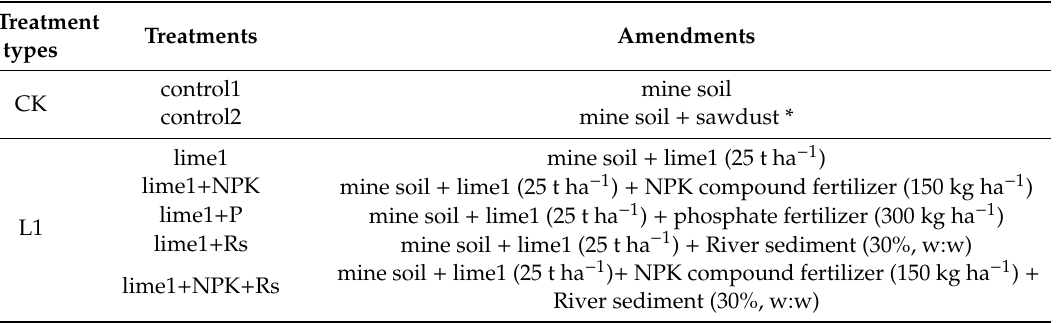
Table 2. Experimental design for pot